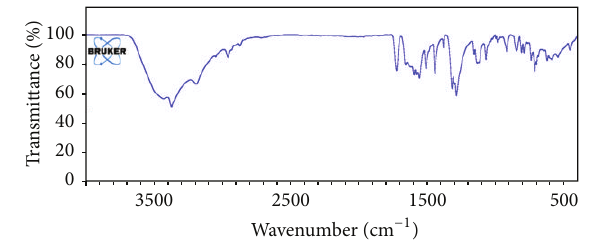
4: Experimental IR spectrum of compound 2C 13 H 12 N 2 O ⋅ H 2